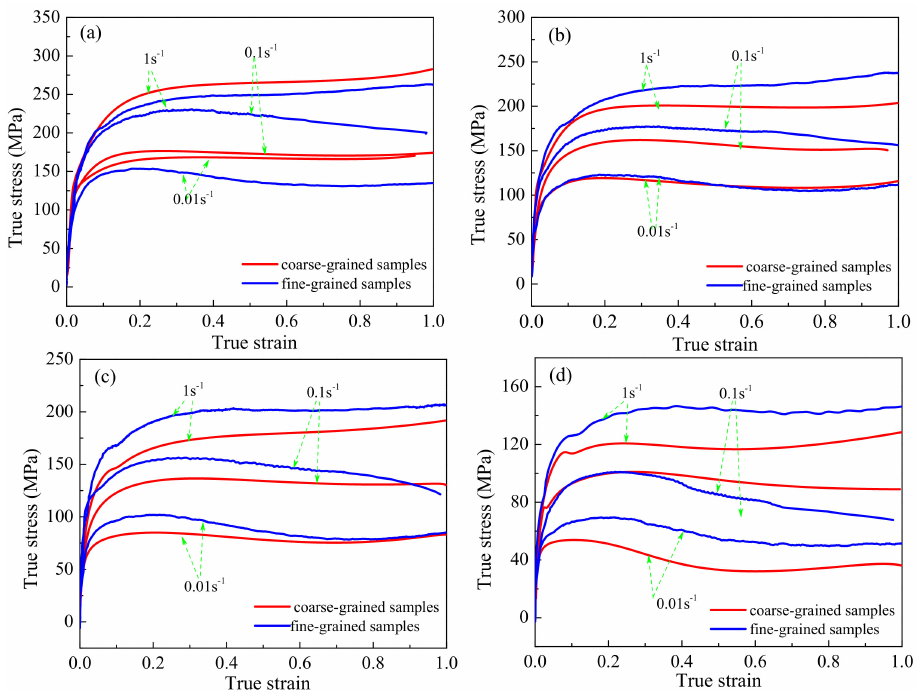
Figure 4. True stress–strain curves of the fine- and coarse-grained samples at di ff erent temperatures: ( a ) 950 ◦ C; ( b ) 1000 ◦ C; ( c ) 1050 ◦ C; ( d ) 1100 ◦